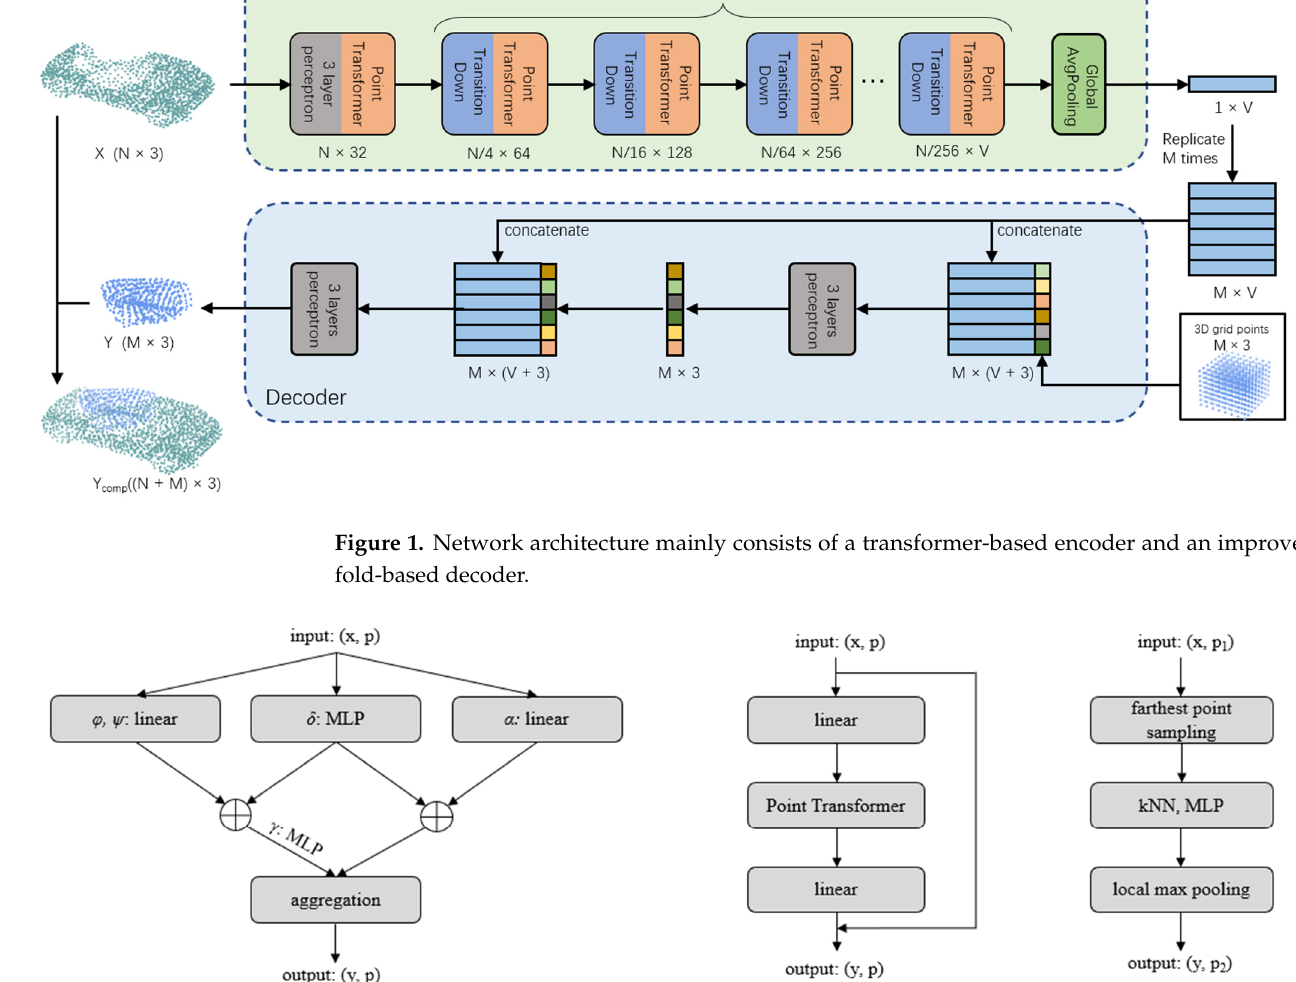
Figure 1. Network architecture mainly consists of a transformer-based encoder and an improved fold-based decoder.